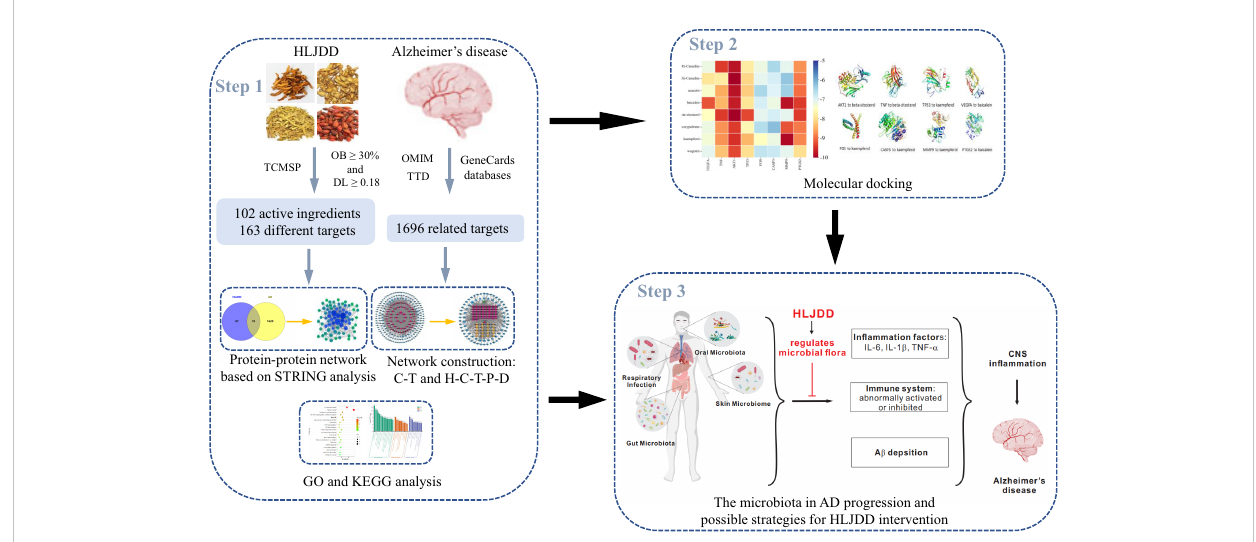
FIGURE 1 The summary and description of the study work fl ow in the potential mechanisms of HLJDD in treating AD. Network pharmacology was used to analyze the crucial ingredients and key targets of HLJDD in the treatment of AD; molecular docking revealed that eight candidate compounds could bind well with eight candidate targets, respectively. It is speculated that HLJDD exerts its anti-AD effect by regulating the homeostasis of microbial fl ora in vivo and inhibiting neuroin fl